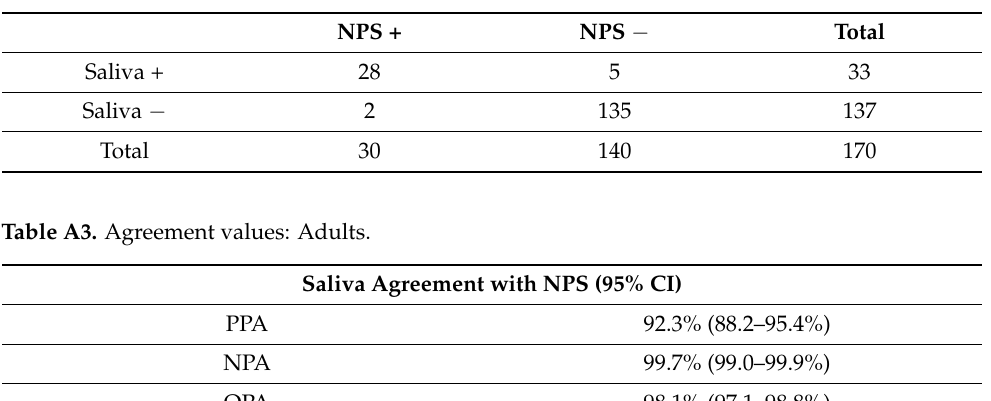
Table A2. Contingency Table: Children.